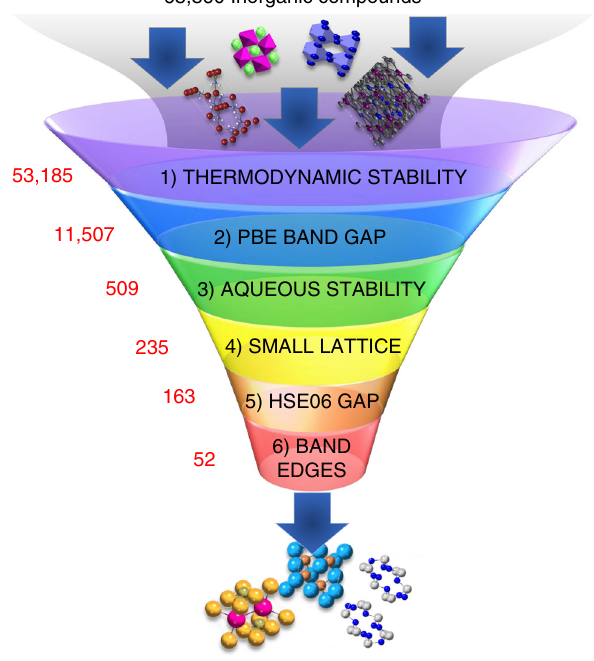
Fig. 2 The selection criteria, as well as the number of materials which satisfy the criterion, are shown for each tier. Note that less than 5% of the semiconductors from tier 2 make it through tier 3, highlighting that very few semiconductors are water-stable at the reducing conditions needed for CO